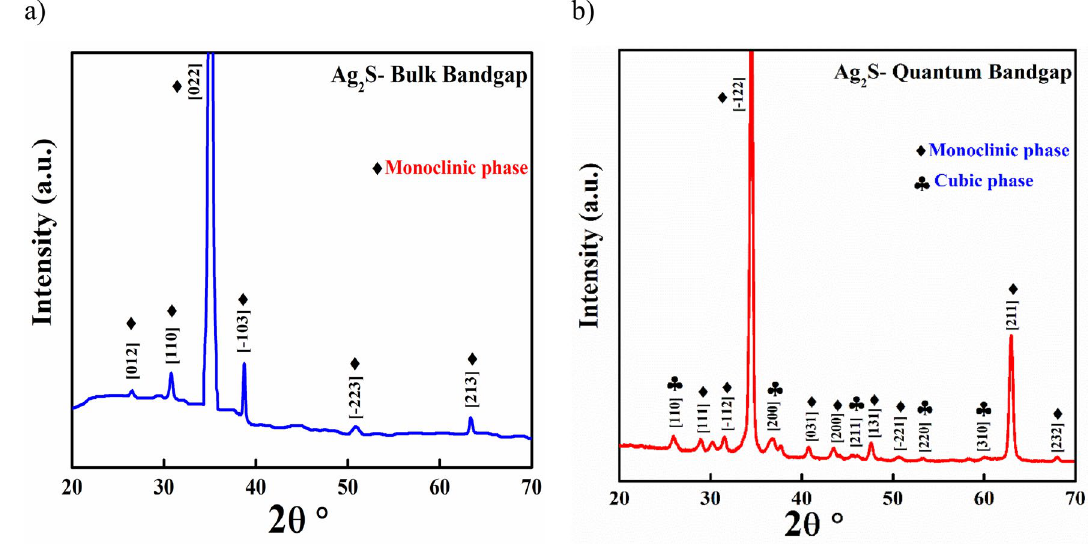
Figure 3. XRD patterns of: ( a ) Ag 2 S nanoparticles, ( b ) Ag 2 S QDs.